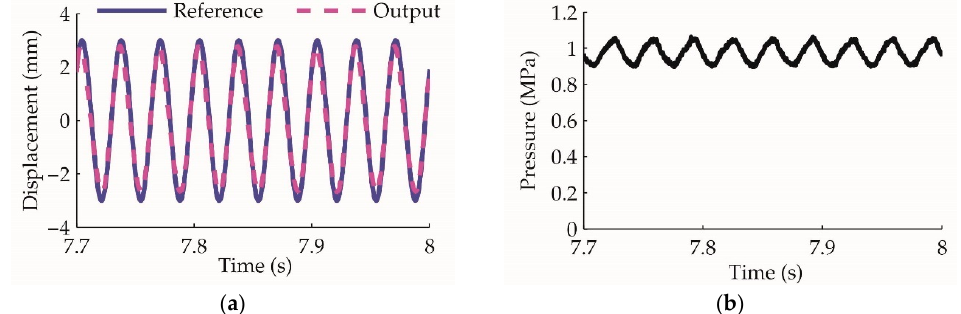
Figure 14. After applying the feedforward control on the linear motor, the mover oscillation experiment: ( a ) displacement reference and output with load; ( b ) the pressure acts on the motor mover, which is equivalent 48 N.